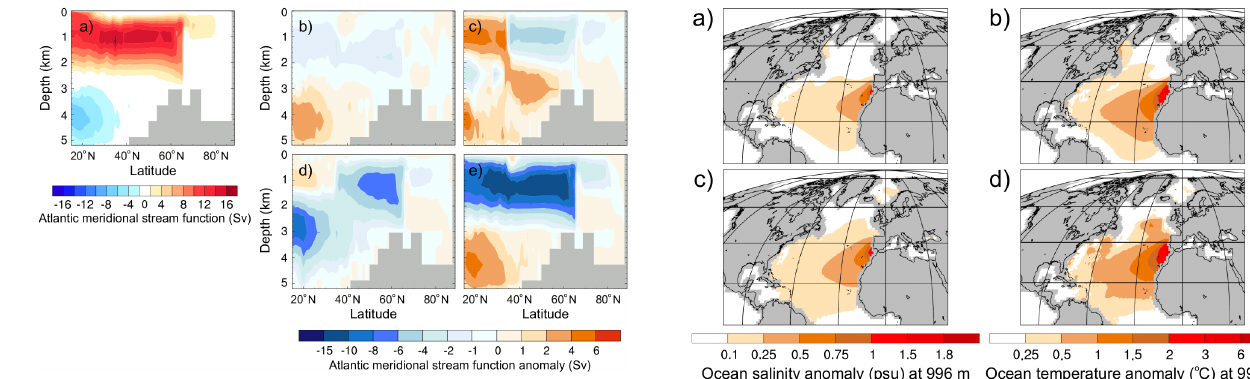
Fig. 6. North Atlantic annual mean difference between a simula- tion with MOW versus a simulation without MOW for (a, c) ocean salinity (inpsu) and (b, d) ocean potential temperature (in ◦ C) both at a depth of 996m, for a modern (pre-industrial) control simulation (top: a, b ) (Ivanovic et al., 2014) and a Messinian simulation (bot- tom: c, d ). Continental landmasses are masked in grey. Note that for orientation, a modern coastal outline is shown, latitude parallels are 20 ◦ apart and longitude parallels are 30 ◦ apart. Figures 7 and 9 also use this